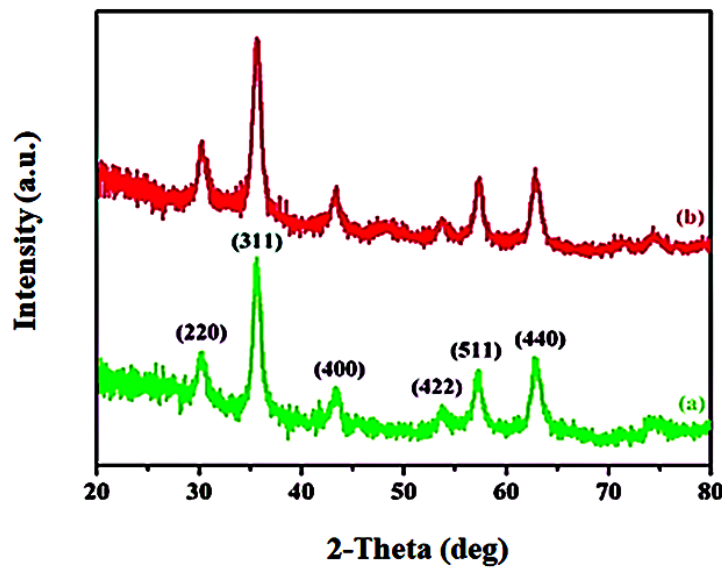
Figure 2. The XRD patterns of Fe 3 O 4 ( a ) and Fe 3 O 4 @PCD - Gd ( b ) nanoparticles.